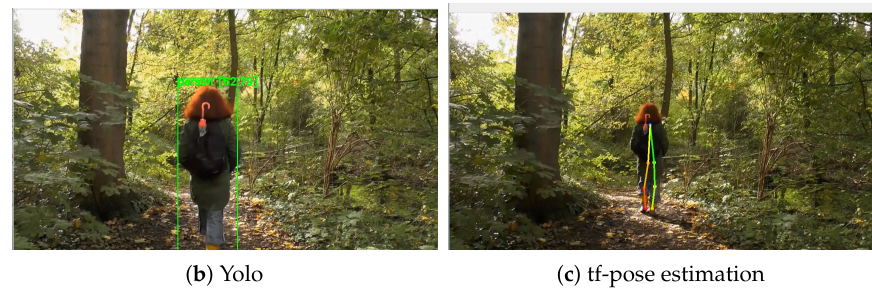
Figure 5. Result of implementation on 1stedge node, 2nd edge node, and cloud